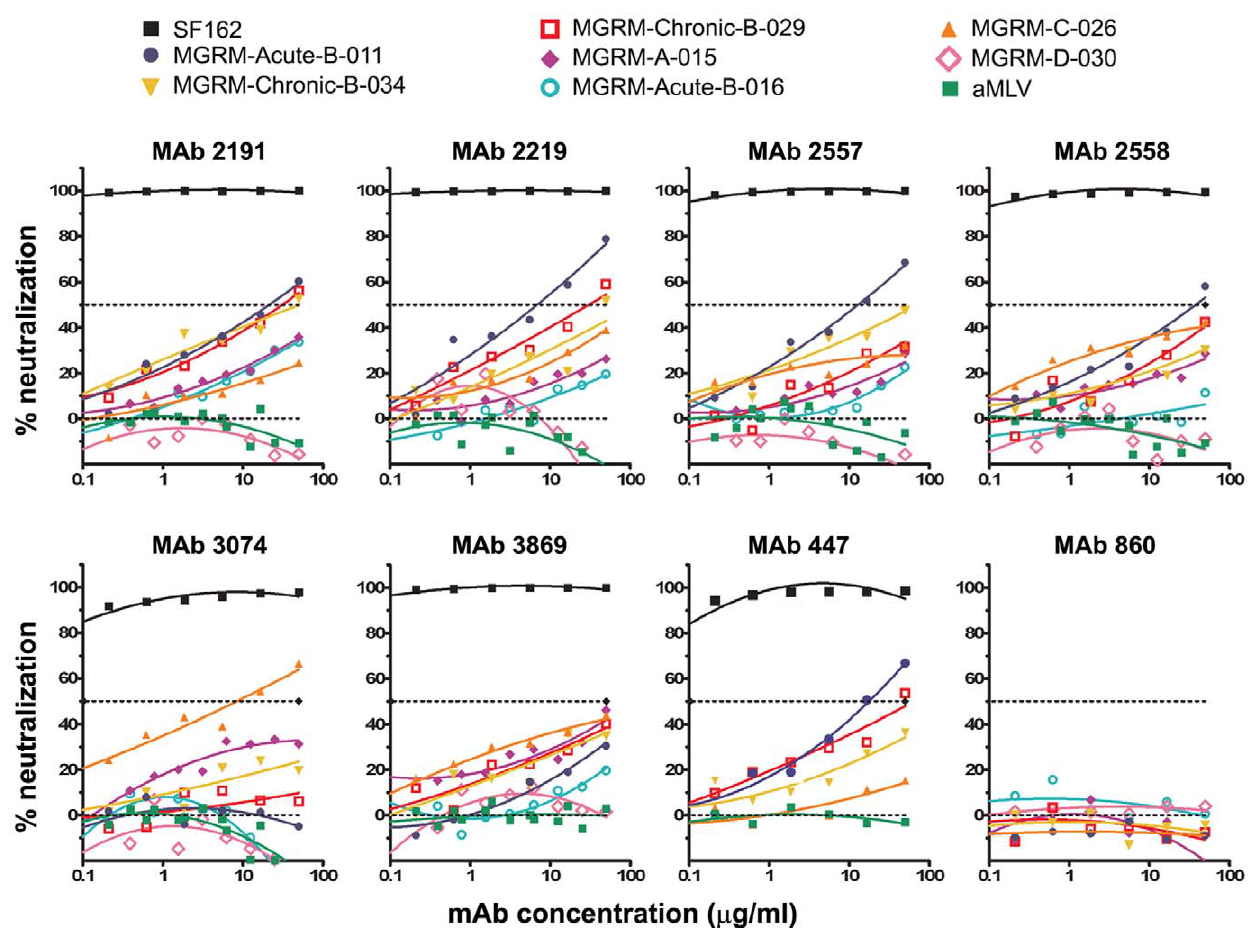
Figure 2. Neutralization curves of anti-V3 mAbs against representative HIV-1 psVs tested using the U87 target cell. Seven anti-V3 mAbs (2191, 2219, 2557, 2558, 3074, 3869, and 447) were tested for neutralization against HIV-1 pseudoviruses using the U87 cell line as target cells. MAb 860, specific for parvovirus, and a pseudovirus expressing the aMLV Env were used as negative controls in this assay. The titration curves from eight selected psVs and the aMLV psV control are shown. Curve fitting was performed using the polynomial regression (quadratic) model described in Materials and Methods. Fifty percent neutralization is denoted by the dashed line. Virus nomenclature is denoted as described in Figure 1.